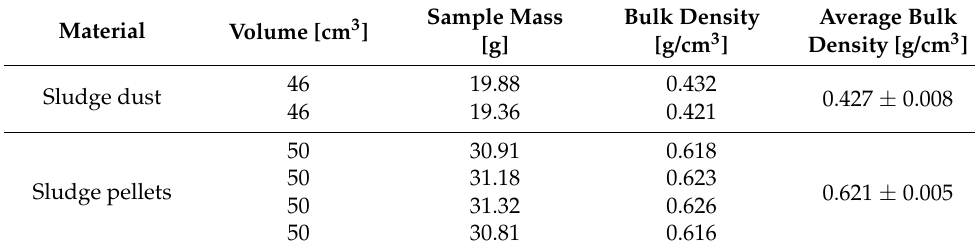
Table 2. The bulk density analysis results.